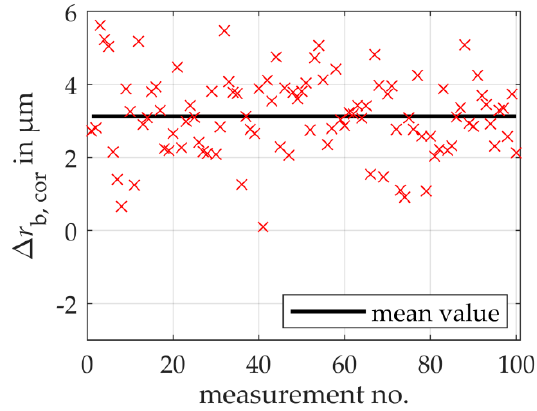
Figure 8. Simulated results of the remaining deviations of the determined mean base circle radii to the corresponding reference base circle radii for repeated measurements on a simulated gear to be measured. On average, a systematic error dominates the total measurement uncertainty.